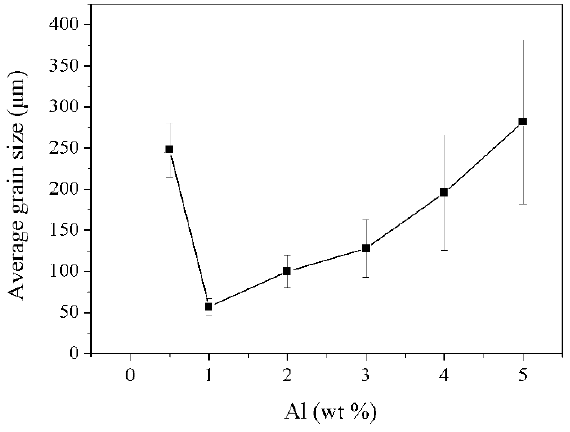
Figure 6. Grain size variation of the as-cast Mg-6Y alloys with additional amounts of the Al.